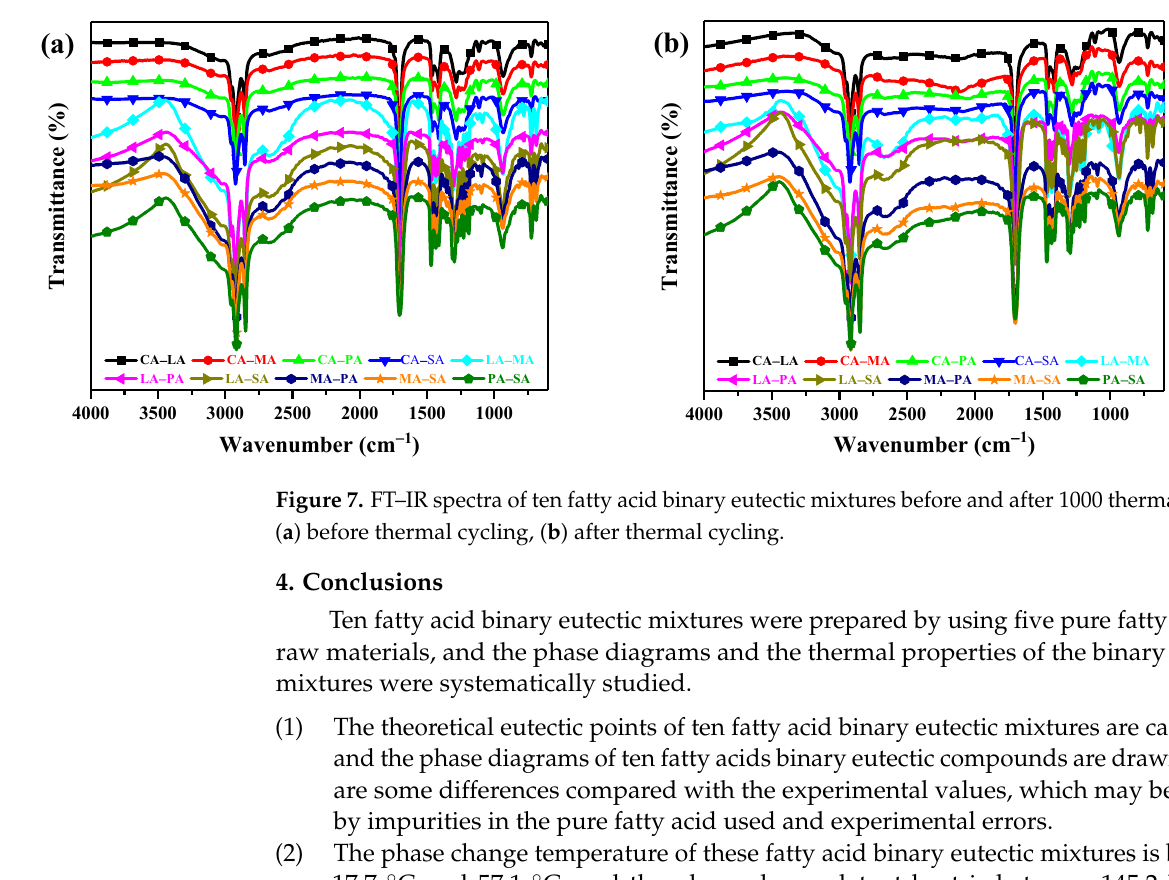
11 of 14 Figure 6. LA–MA PCMs DSC curves before and after thermal cycling. The samples of LA–MA PCMs eutectic mixtures were measured by FTIR to judge whether the composition of the mixture has changed before and after thermal cycling,